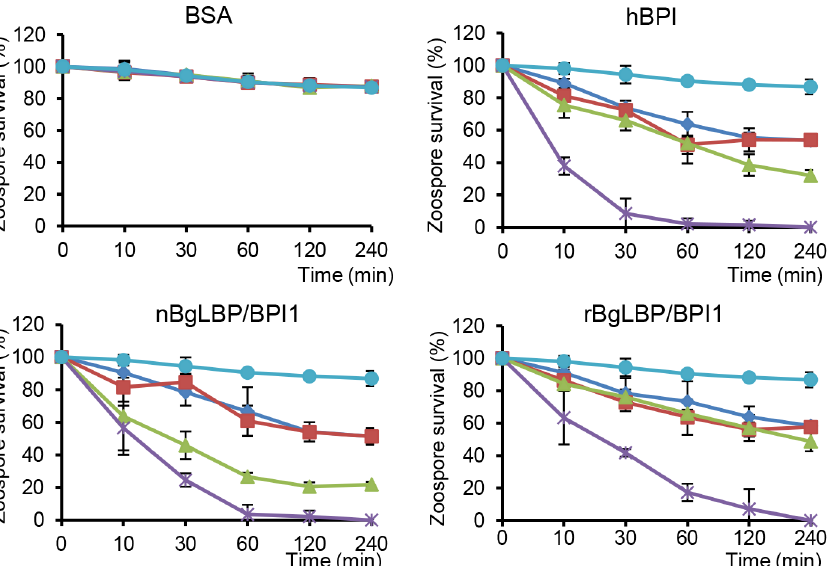
Figure 5. BgLBP/BPI1s and hBPI display anti-oomycete activity against P.parasitica zoospores. Survival rate of P. parasitica zoospores after exposure to BSA, hBPI, rBgLBP/BPI1 and nBgLBP/BPI1. Zoospores were incubated with proteins at 5 (dark blue), 10 (red), 30 (green) and 100 m g/ ml (purple). Negative controls (light blue) are zoospores without treatment. Results are mean percentages ( 6 SE) of three independent experiments.